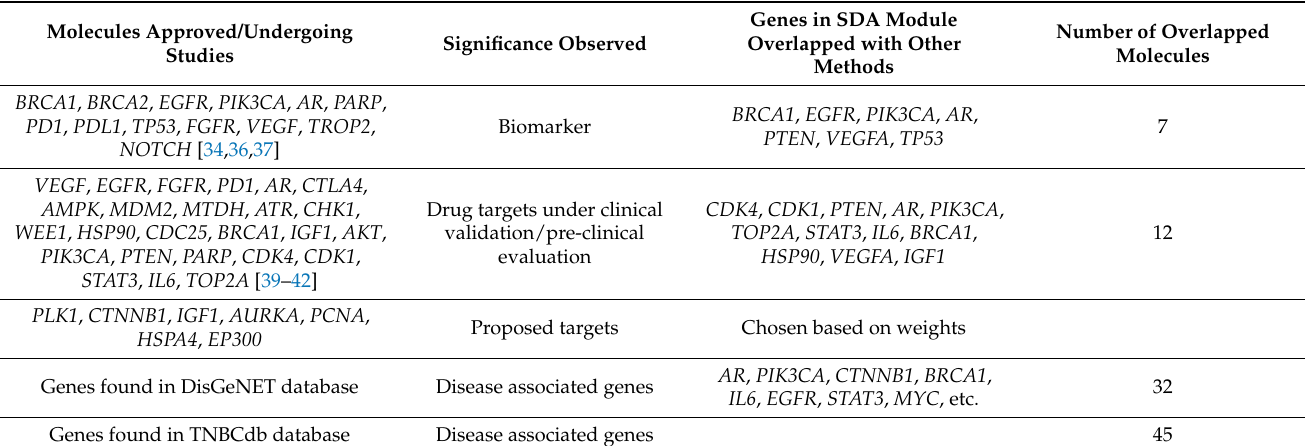
Table 2. Module gene associations with diseases for TNBC gene set, verified with other